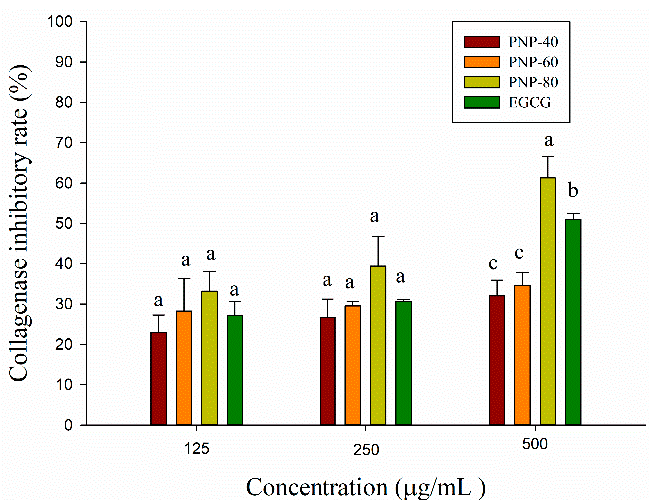
Figure 3. Anti-collagenase activity of PNPs (125, 250, 500 µg/mL) and EGCG (125, 250, 500 µg/mL). The experiments were conducted in triplicate independently ( n = 3), and the data are expressed as the means ± standard error (SE). a–c Means within the same concentration followed by the same letter were not significantly different ( p > 0.05).